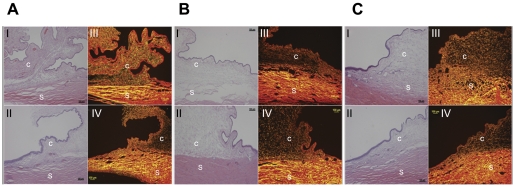
Histology of rabbit eyes.Group A: topical latanoprost eyedrops. Group B: subconjunctival latanoprost liposomes. Group C: subconjunctival latanoprost-free liposomes. Histology revealed no abnormal scarring or damage to the collagen layers in both H&E stain (Photos I and II) and Picrosirius red stain (Photos III and IV; Grade 1 for all eyes). S = Sclera; C = Conjunctiva.